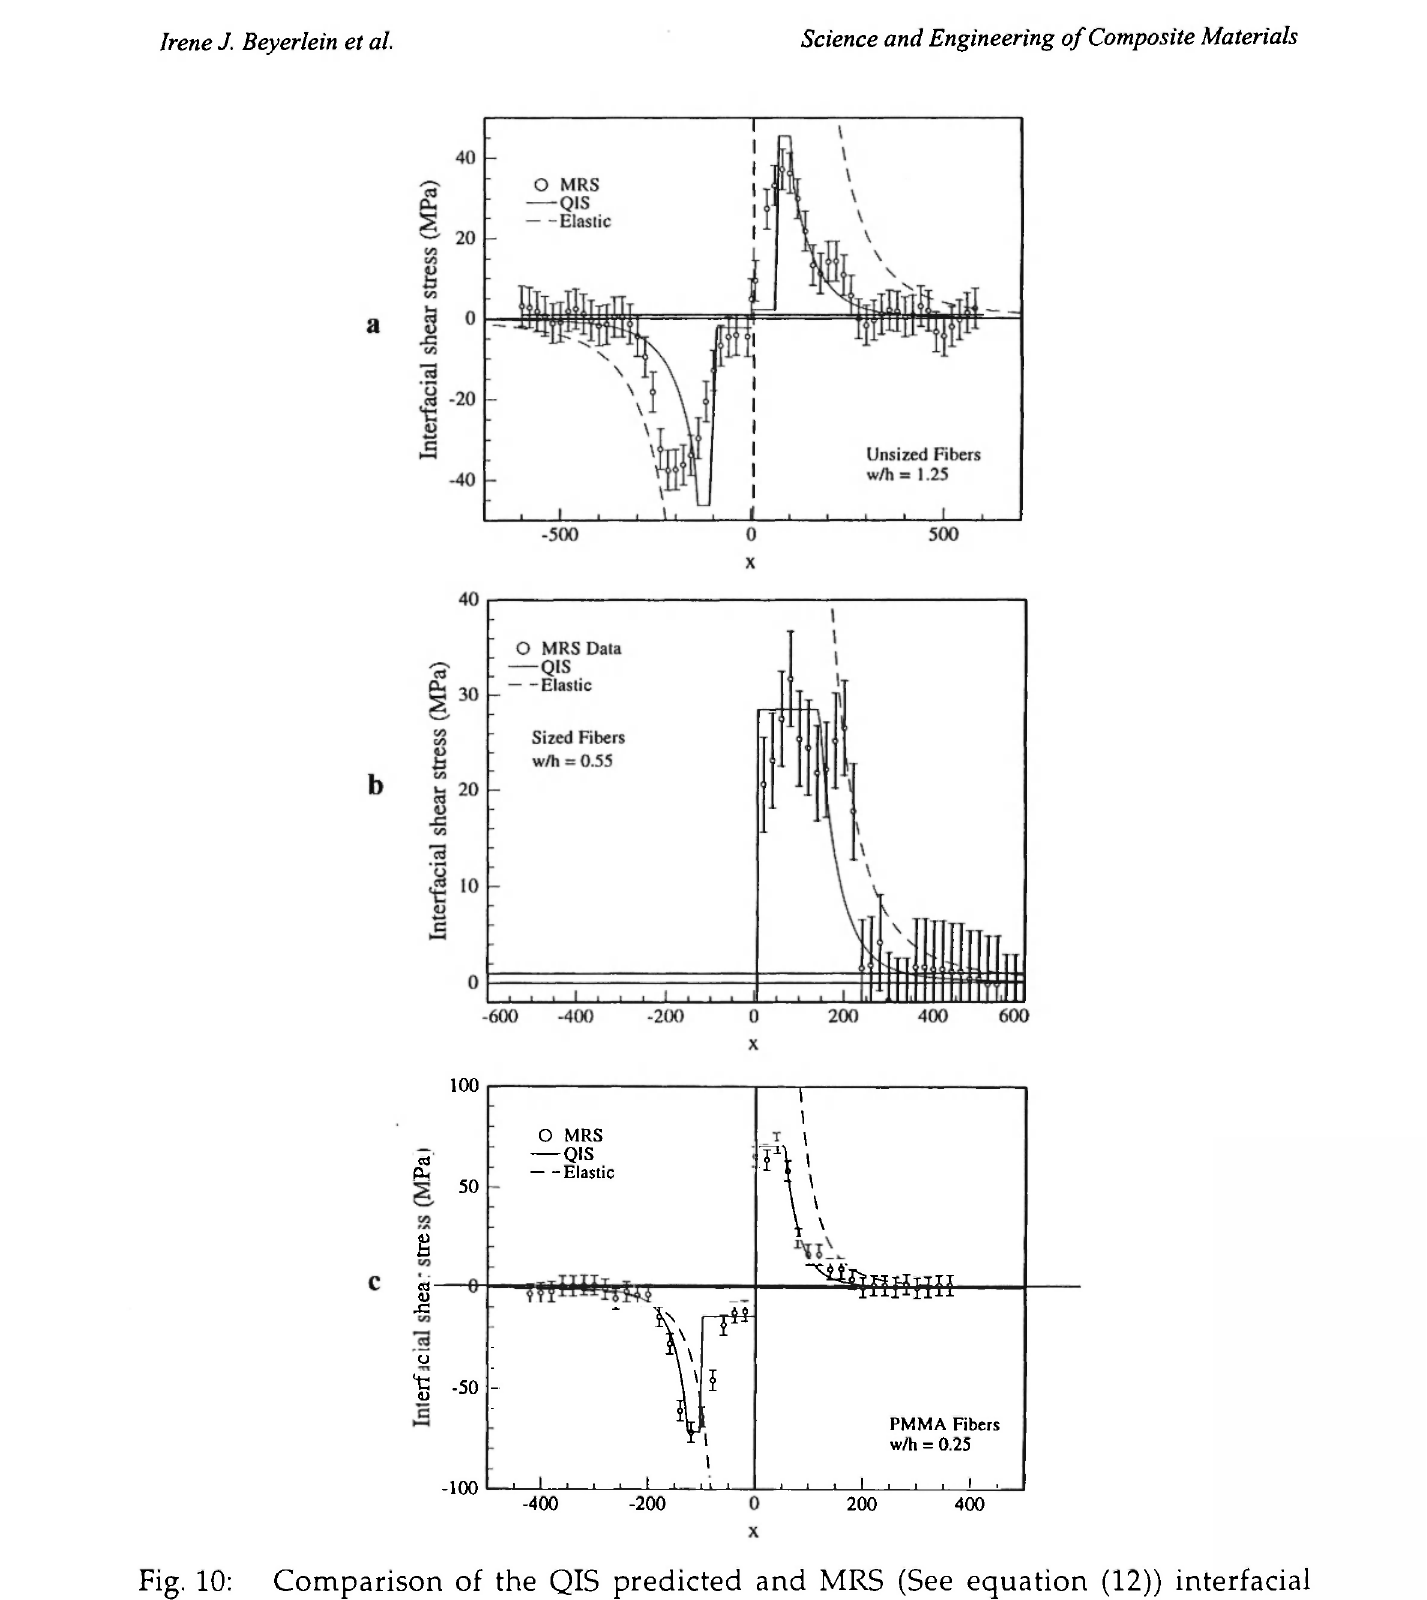
Fig. 10: Comparison of the QIS predicted and MRS (See equation (12)) interfacial shear stress profiles along broken (a) unsized fiber where w/h - 1.25, (b) sized fiber where w /h = 0.55, and (c) PMMA coated fiber where w /h =